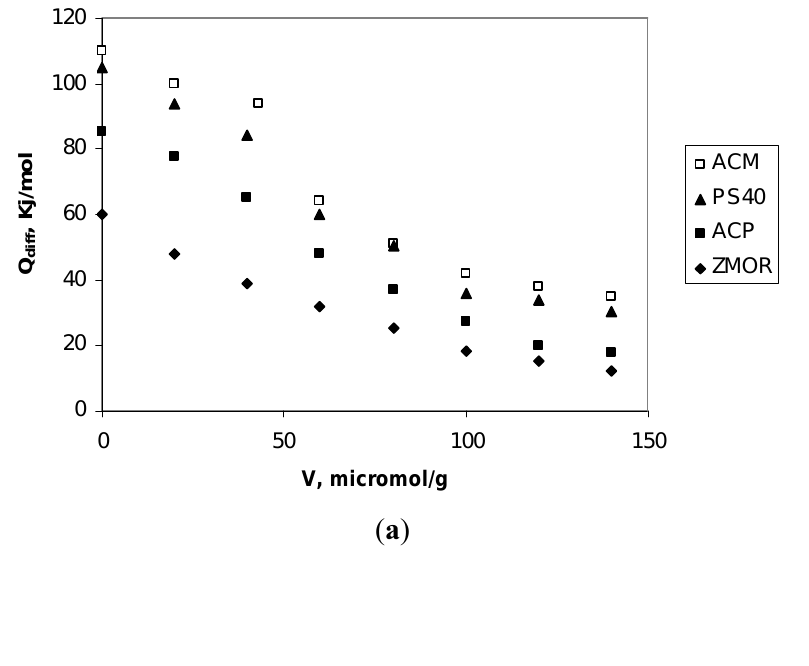
Figure 3. Differential heats of adsorption on ACM at 323 K: ( a ) adsorption of N ( b ) adsorption of CO; ( c ) adsorption of CO on ACM previously contacted with N cases, the samples were activated at 973 K in